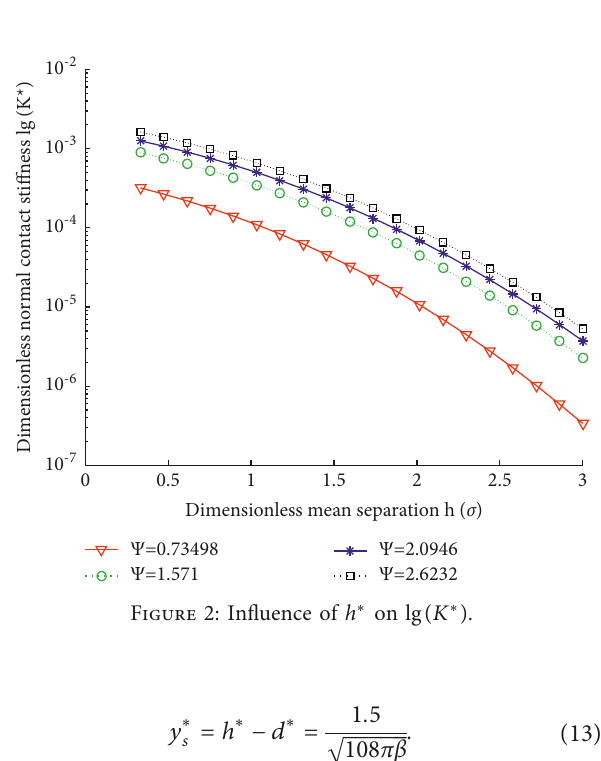
Figure 2: Influence of h ∗ on lg ( K ∗ ) .